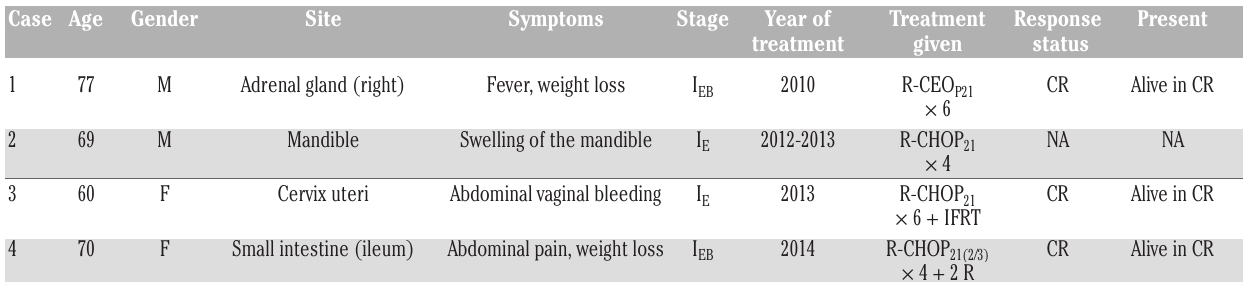
Figure 1. Representative images of morphologic variants of diffuse large B-cell lym- phomas in the current study (Hematoxylin and Eosin stain, magnification ×400). Centroblastic (a); Immunoblastic Table 1. Demographics of patients with extranodal diffuse large B-cell lymphomas.